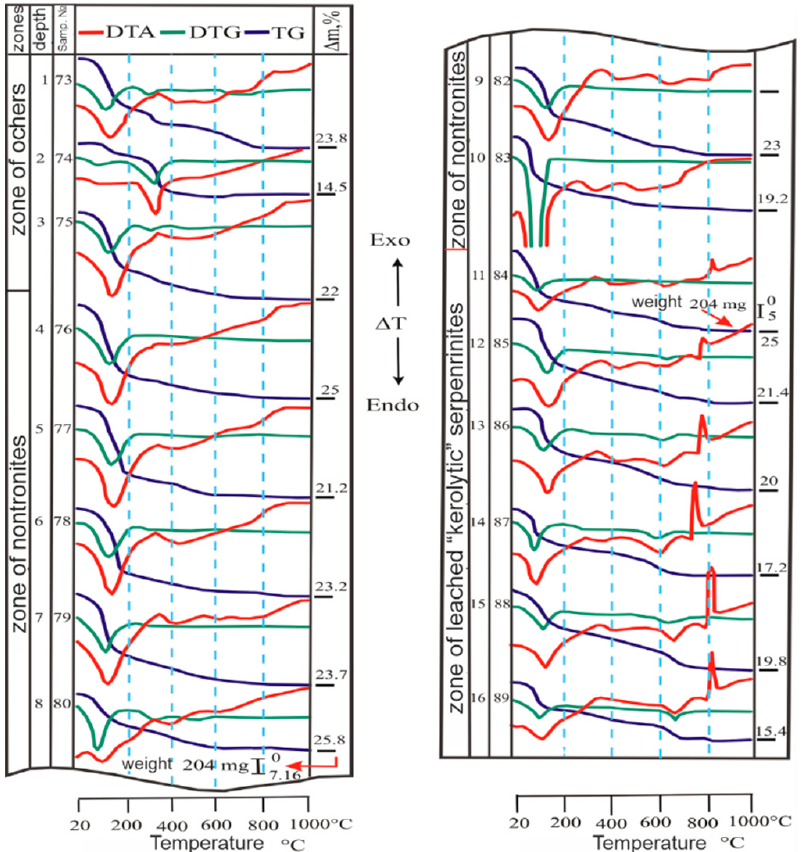
Figure 7. Buranovskoye deposit—serpentine-to-kerolite transformation zone, samples 84–89. Derivatograms of hypergenesis products from weathering crusts of the full profile. DTA—250 µV, DTG—500 µV, TG—100 vu (500 µV), and sample—500 mg. Exo—exothermic effect, Endo—endothermic effect, ∆ T—change in the enthalpy of the system during the thermal transformation of the tested samples.